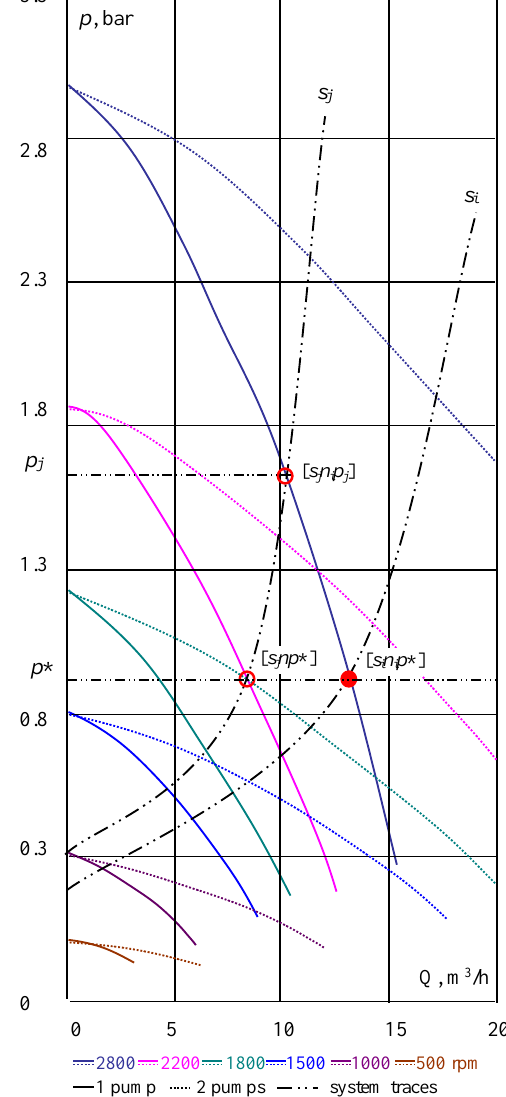
Fig. 1. A family of Qp -curves for Ebara CDX